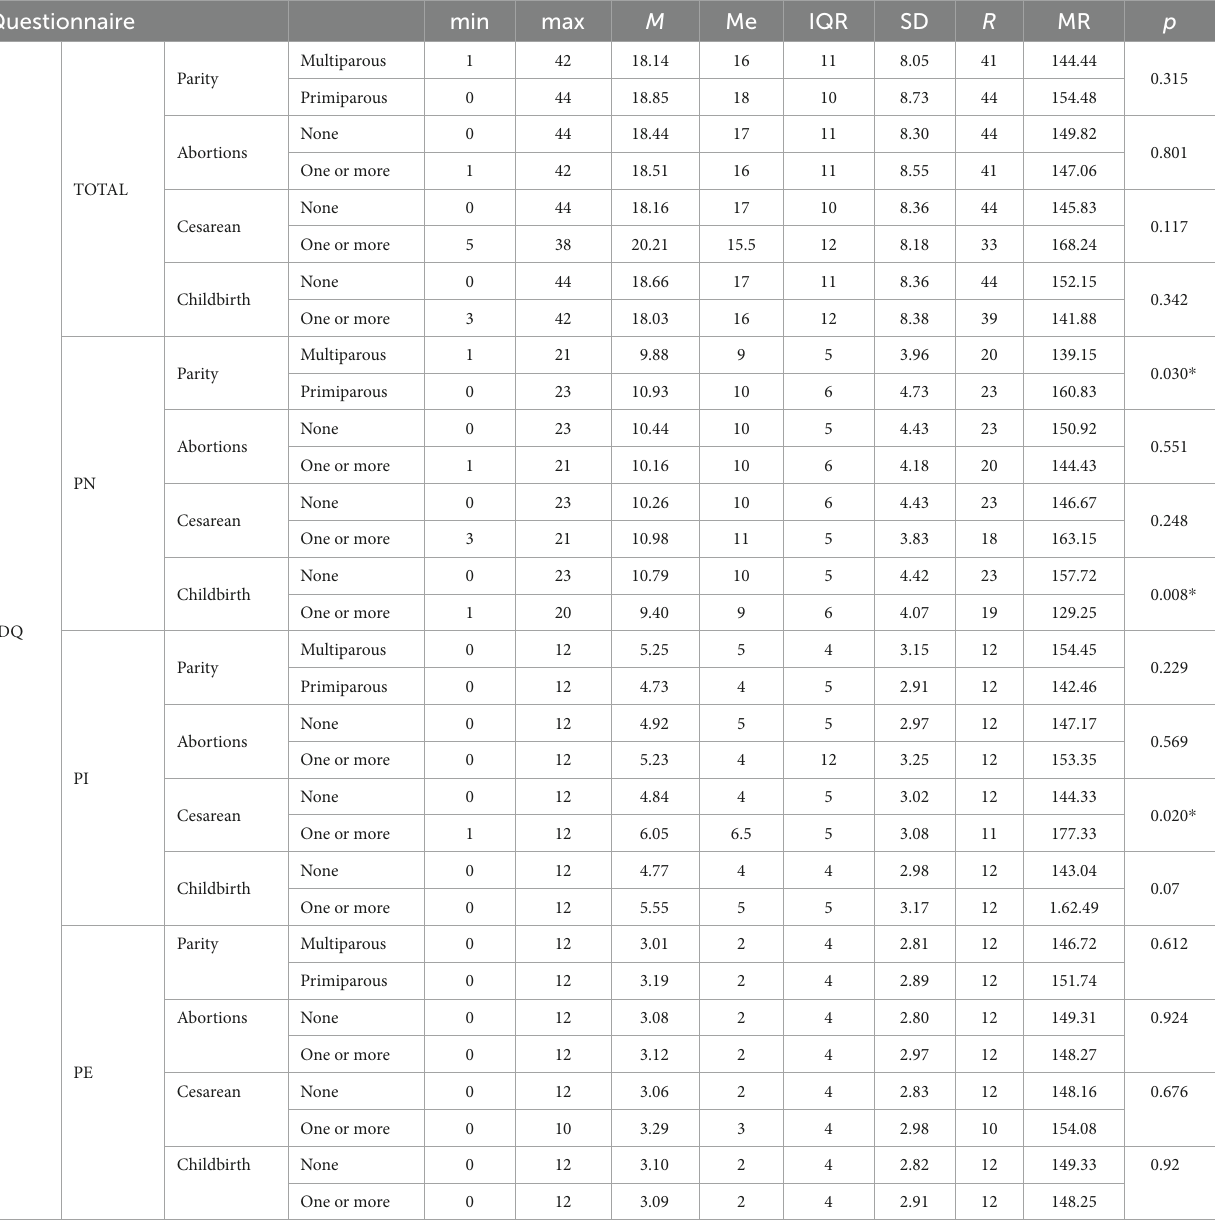
TABLE 3 Descriptive statistics of prenatal concerns according to parity, abortions, cesarean, and childbirth.